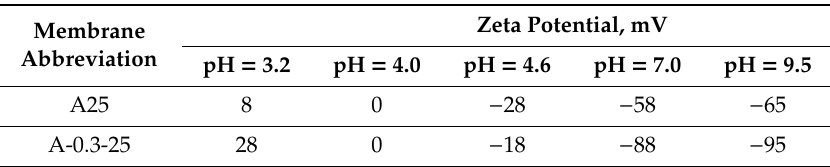
Table 3. Zeta potential of the membrane skin layer.